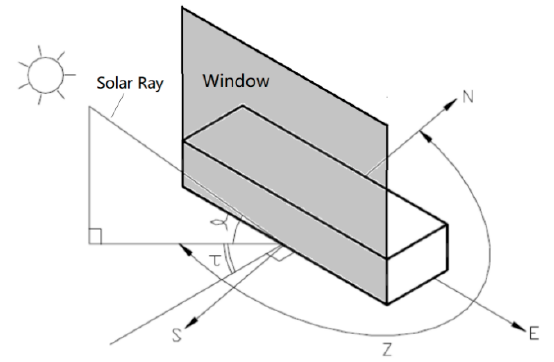
Figure 6. Solar Figure 6. Solar geometry.